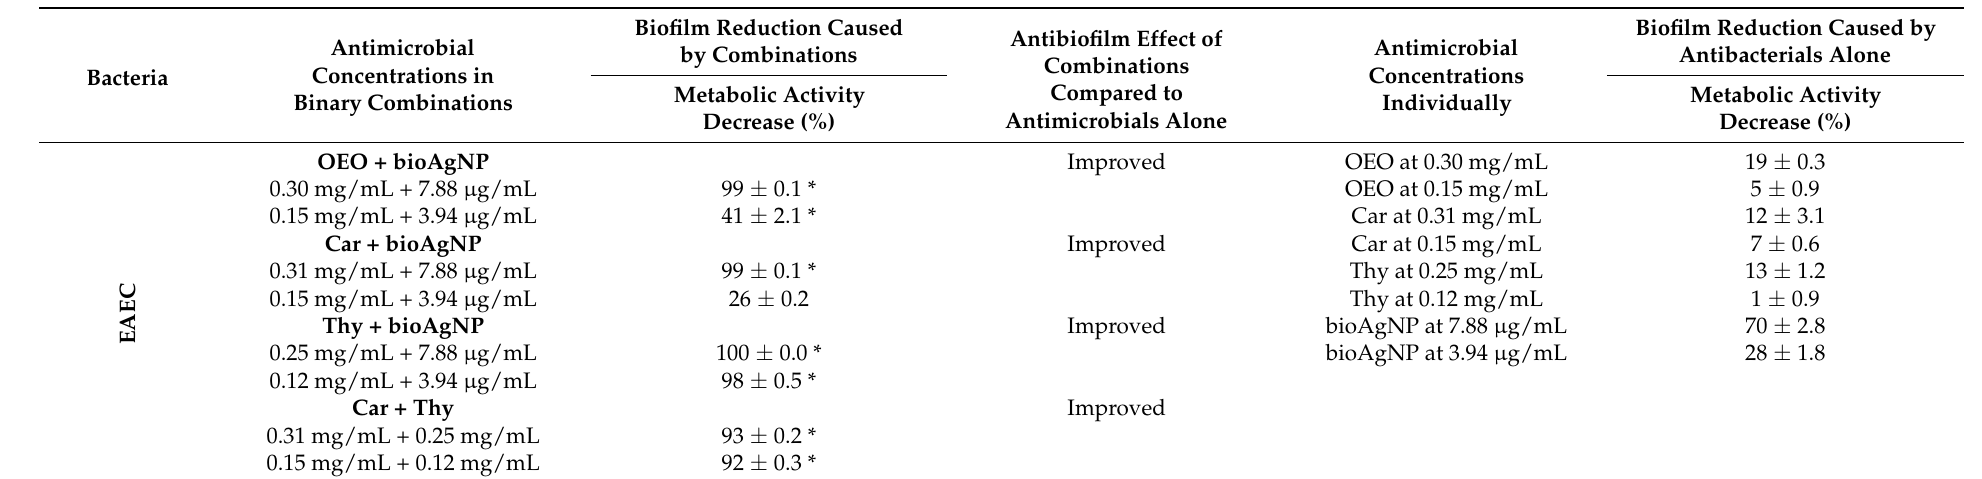
Table 5. Antibiofilm effect, which is shown in terms of metabolic activity reduction of oregano derivatives and biological silver nanoparticles (bioAgNP) compared to both antimicrobials individually against enteroaggregative Escherichia coli (EAEC 042) biofilms growth in microtiter plates, which were evaluated at preformed biofilm